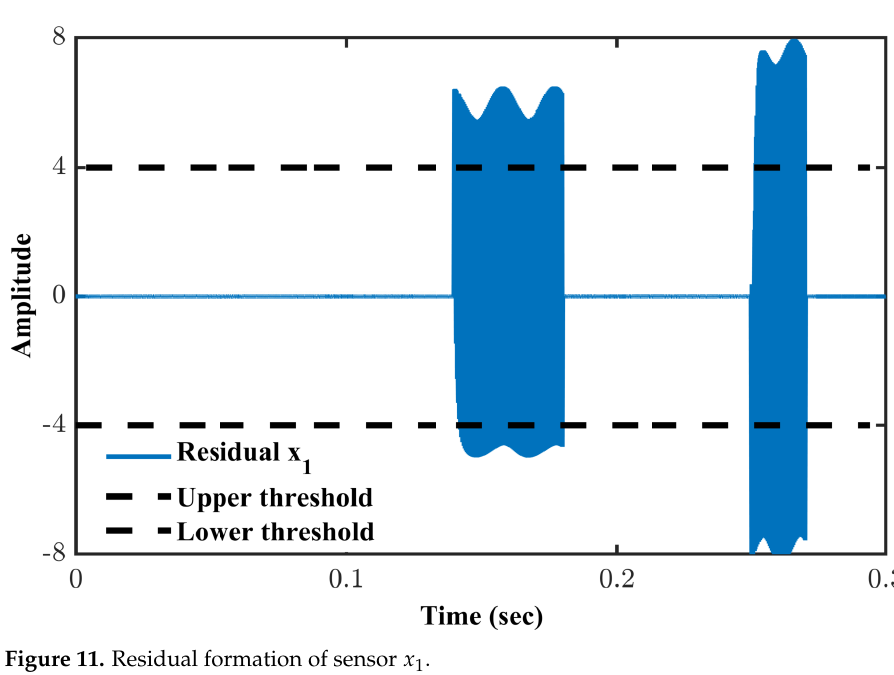
Figure 11. Residual formation of sensor x 1 .